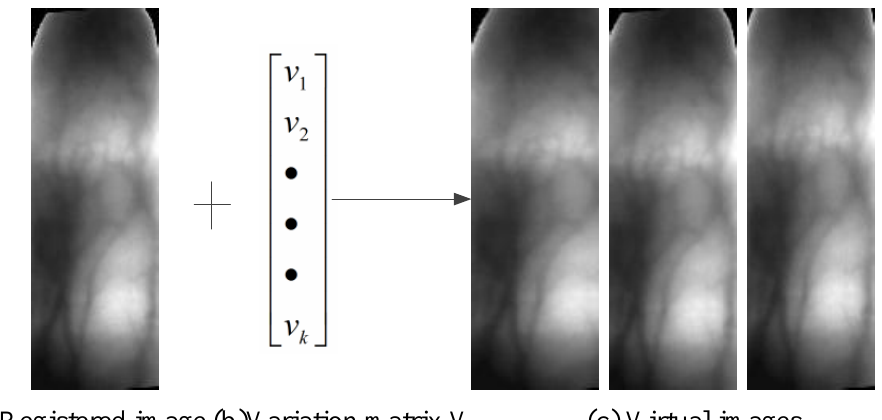
Figure 5. The process of virtual image generation.